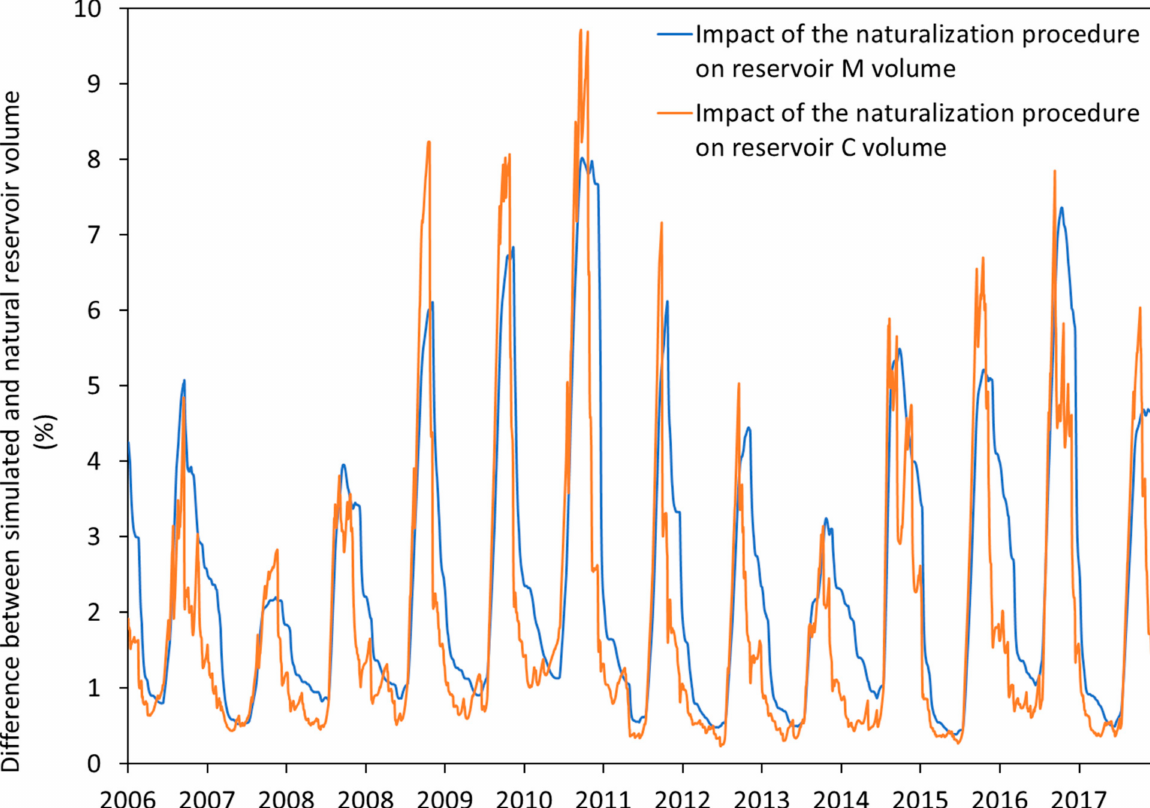
Figure 6. Temporal variability of the impact of the naturalization procedure on the total daily water available in the conceptual reservoirs M and C of the calibrated